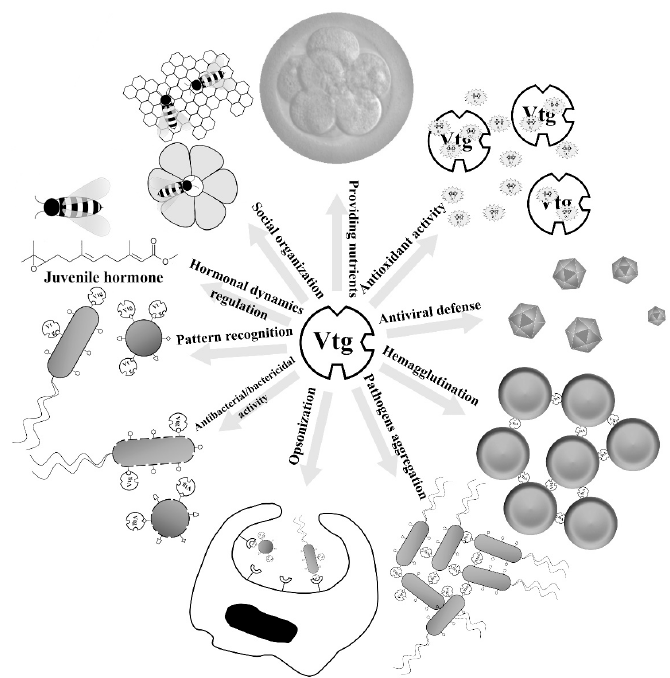
Figure 2. Multiple roles of vitellogenin (Vtg). Vtg is traditionally thought to provide protein- and lipid-rich nutrients for developing embryos and larvae. However, accumulating data demonstrate that its roles extend beyond the nutritional function. In the advanced eusocial insect honeybee, Vtgs were shown to be associated with the social organization, temporal division of labor and foraging specialization, regulation of hormonal dynamics and change in gustatory responsiveness. Recent studies show that Vtgs also play immune-relevant roles. Vtg is able to recognize the invading microbes as a multivalent pattern recognition receptor, kill bacteria or neutralize virus as an effector molecule as well as enhance phagocytosis as an opsonin. Besides, Vtg also exhibits activities to hemagglutinate erythrocytes and aggregate pathogens. In addition to immune roles, Vtg plays another novel role as an